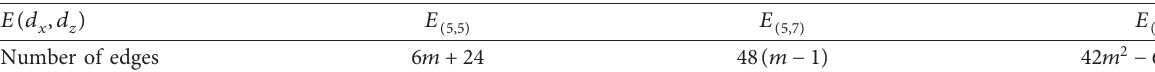
Table 3: Separation of